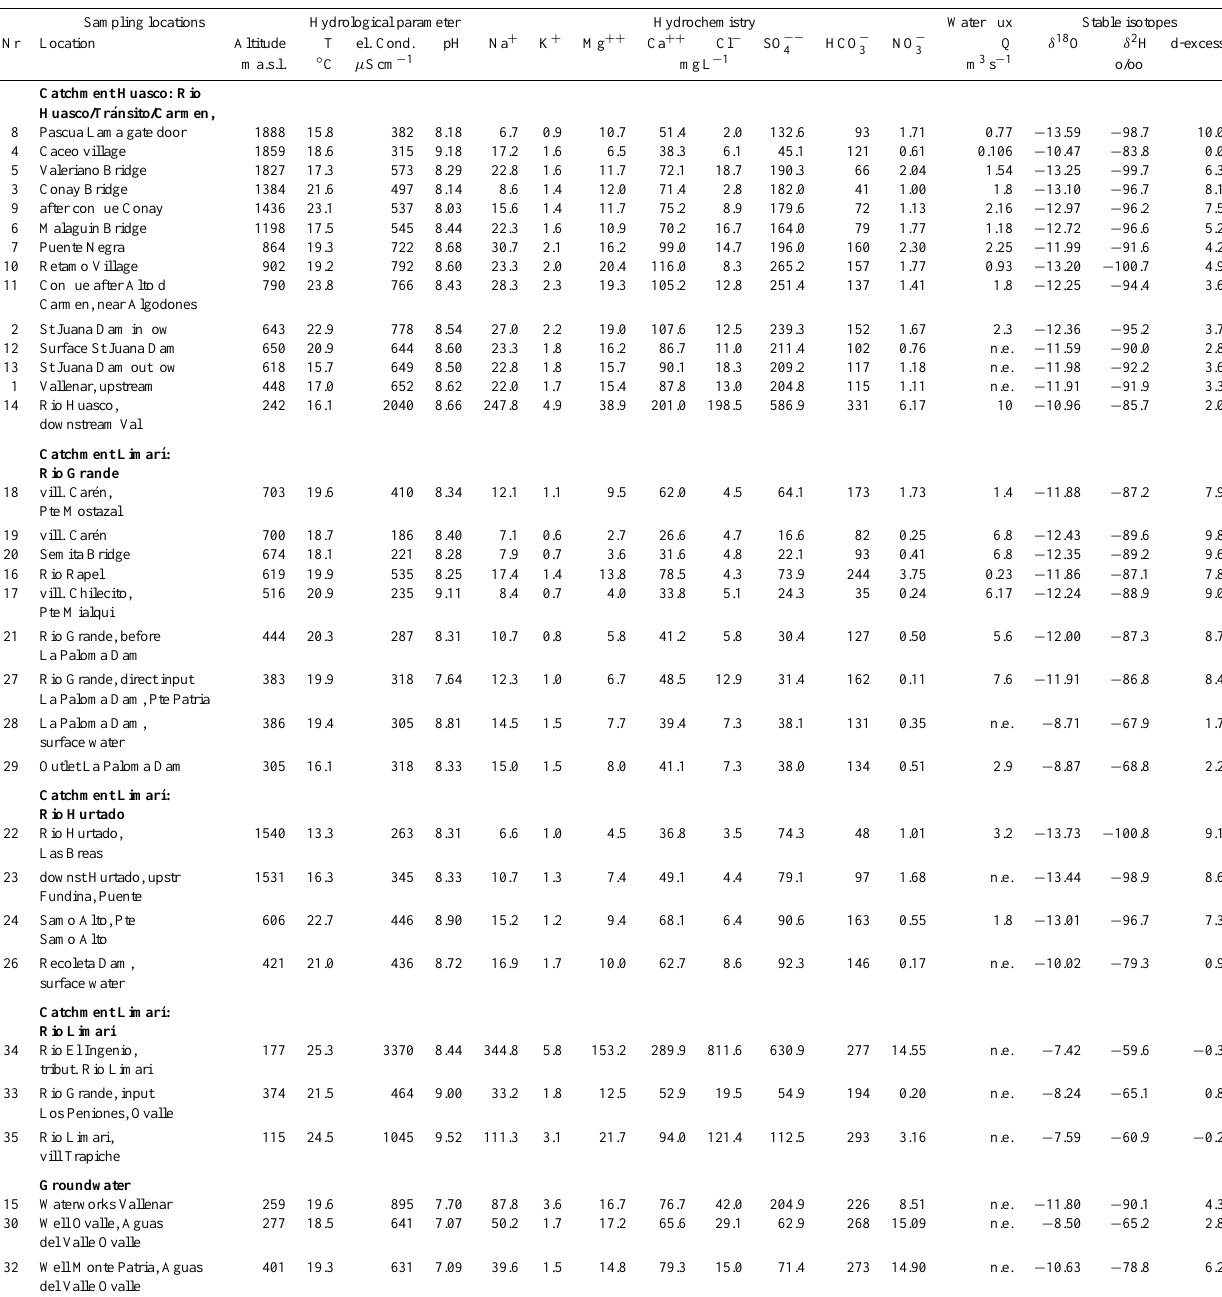
Table 2. Sampling location characteristics, hydrochemical and isotope data including water flux estimations during sampling. The sampling was from 11 to 15 November, 2006. Sampling